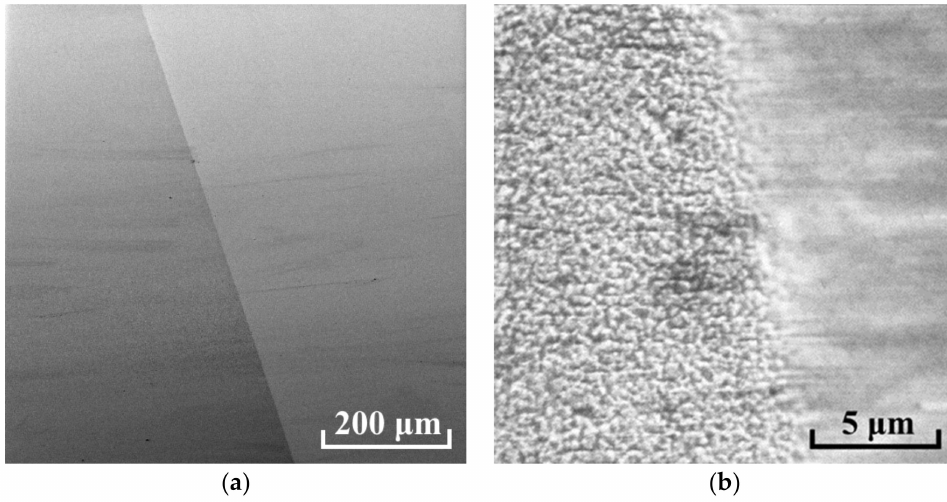
Figure 9. SEM images of the border between as-prepared (left sides) and smoothed areas (right sides) of AlN film on Sitall substrate for different magnifications marked by scale bar: ( a ) 200 µ m, ( b ) 5 µ m. Chemical mapping experiments have shown that these areas differ in chemical com- position (Figure 10). In the untreated (right) area, the contents of the main elements Al, N, and O were, respectively, 44.2, 40.2, and 3.5%, whilst in the polished (left) area, the contents were, respectively, 43.2, 39.4, 5.8%. It is also worth noting the different carbon contents in these areas, although the sample was wiped with ethyl alcohol before loading into the microscope, which could change the chemical composition. It should be noted that the EDX map was mirrored due to the peculiarities of the experiment.